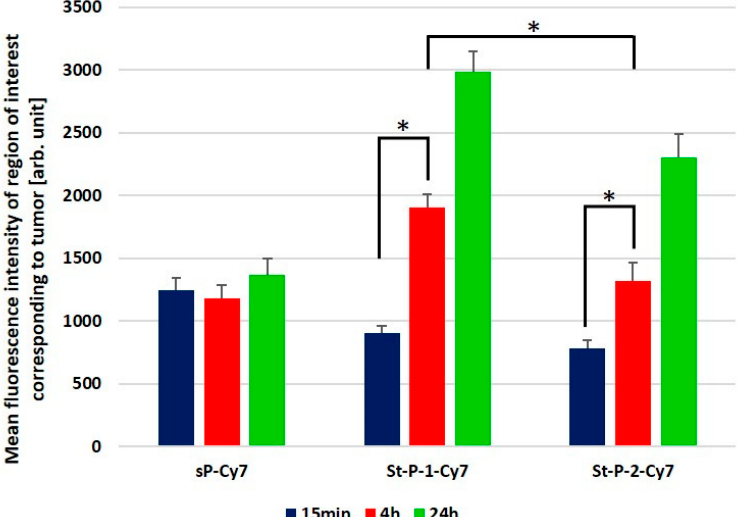
Figure 4. In vivo tumor accumulation of different molecular weight polymer probes ( sP-Cy7, St-P-1-Cy7 and St-P-2-Cy7) with the same percent (2.4%) weight of Cy-7 fluorescent dye. MFI was determined by the In-Vivo Xtreme In Vivo Imaging System. The data are presented as the mean ± SEM of duplicates from two independent experiments. * P values < 0.001. Number of mice n = 8.